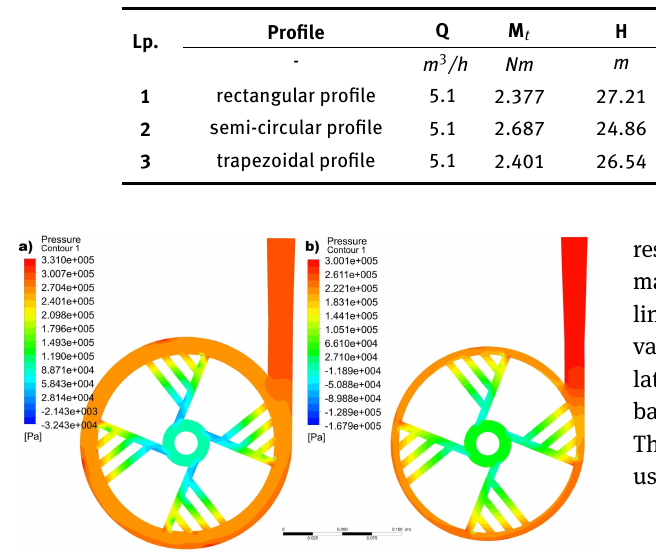
Figure 14: Distribution of static pressure on the model central plane (a) base annular casing VB and (b) final annular casing VM